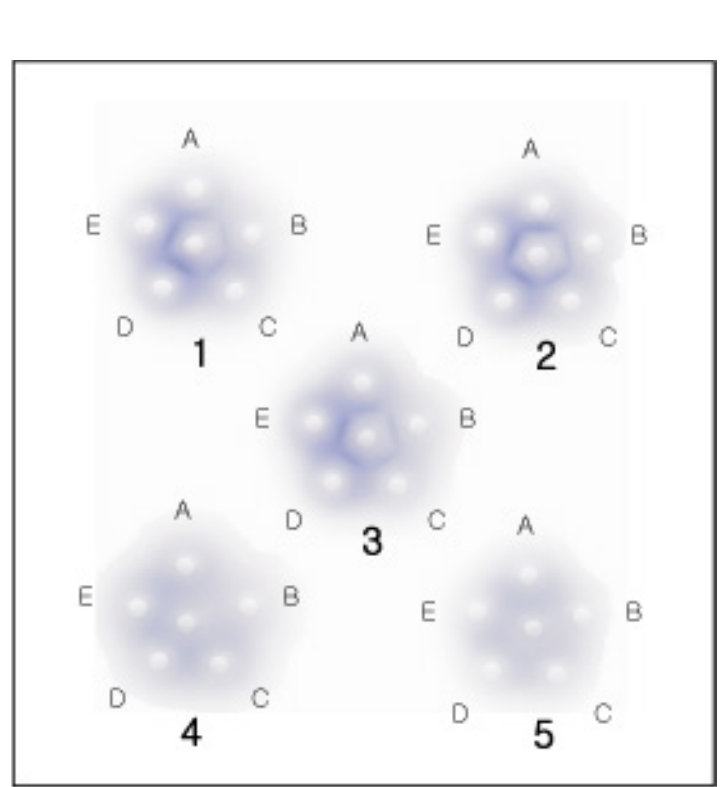
Figure 6: Analysis of Ouchterlony reactions. Venoms in central wells – 1: Agkistrodon halys venom lethal fraction; 2: Jiangzhe Agkistrodon halys venom; 3: Agkistrodon halys venom hemorrhagic fraction; 4: Bothrops atrox venom; 5: Agkistrodon rhodostoma venom. Antivenoms in peripheral wells – A: Agkistrodon halys antivenom (2U); B and C: Jiangzhe Agkistrodon halys antivenom (2U); D: Jiangzhe Agkistrodon halys antivenom (1U); E: Agkistrodon halys antivenom